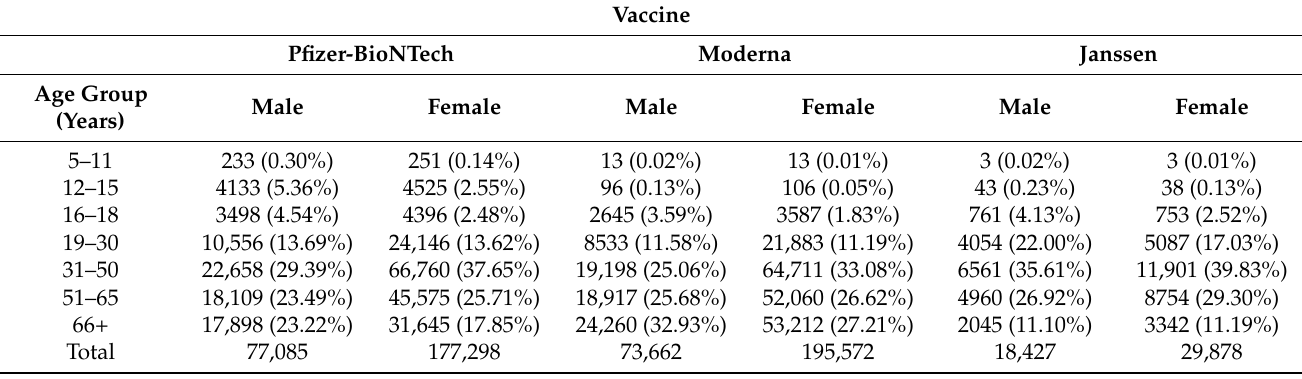
Table 5. Number of VAERS reports categorized with respect to the age group and gender along with their percentage per the three vaccine producers. For robust statistical analysis of vaccine data, duplicate reports were merged into distinct rows resulting into 643,522 rows compared to the total 905,976 reports with